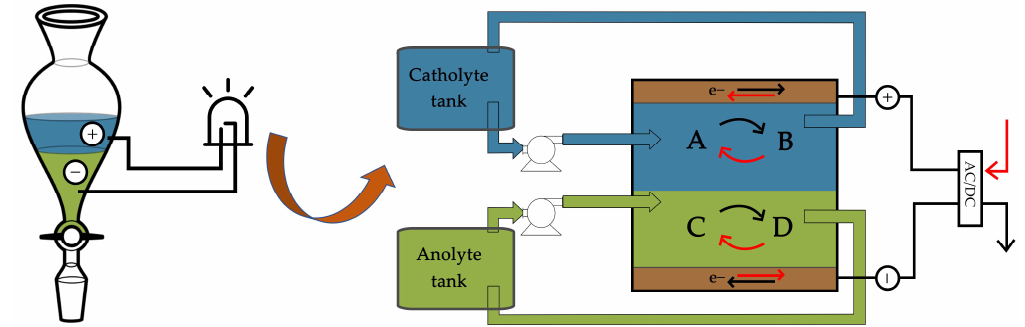
Figure 9. Schematic diagram of the working principle of an immiscible membraneless RFB. Adapted from Ref. [227], Copyright 2017, John Wiley and Sons.